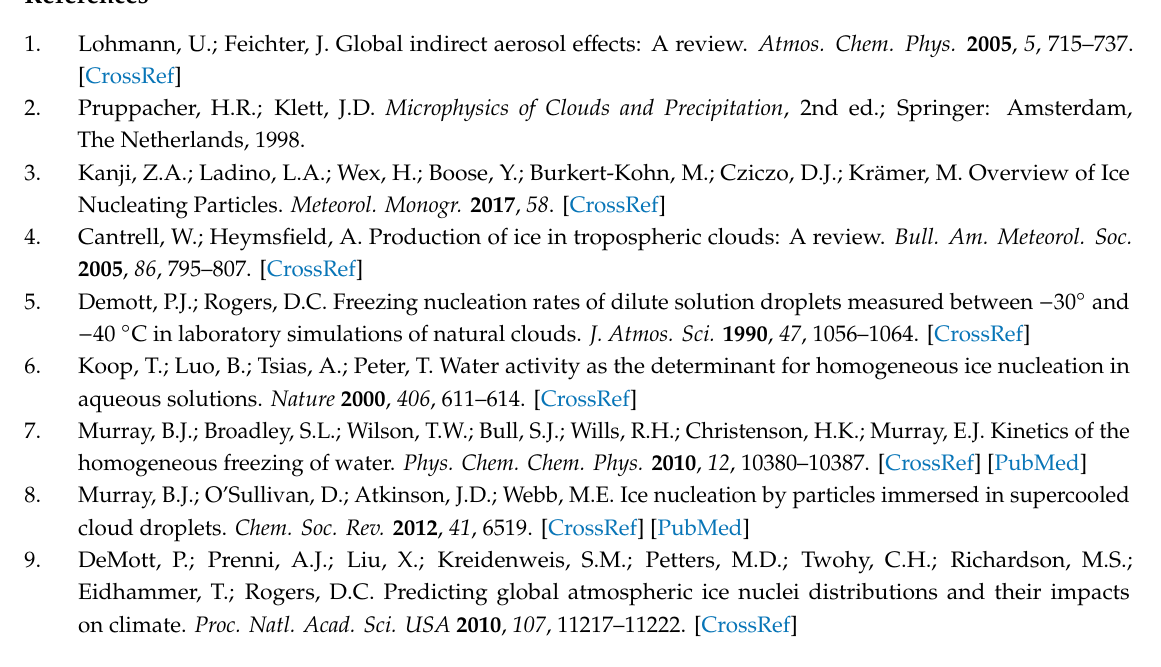
Figure S1: Sampling location of the atmospheric particles (Kanazawa University, 36.54 ◦ N, 136.70 ◦ E; 149 m a.s.l.). Figure S2: Activated fractions for D P > 1.1 µ m particles as a function of temperature. Figure S3: Raman (a) and EDX (b) spectra of the representative identified INPs. Table S1: Summary of the activated fractions and the weather condition during sampling periods. Table S2: Summary of the chemical characterization of INPs based on the micro-Raman and EDX